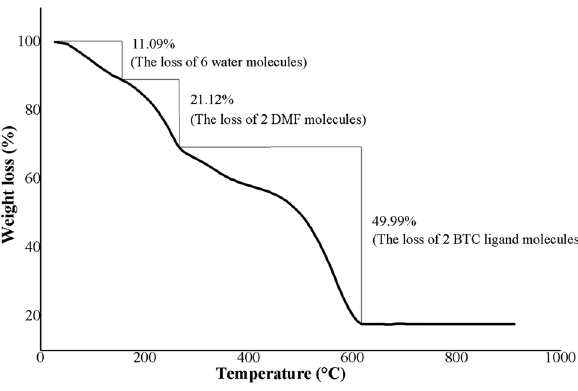
Figure 9: Thermogram of the synthesized MIL - 100 ( Al ) .